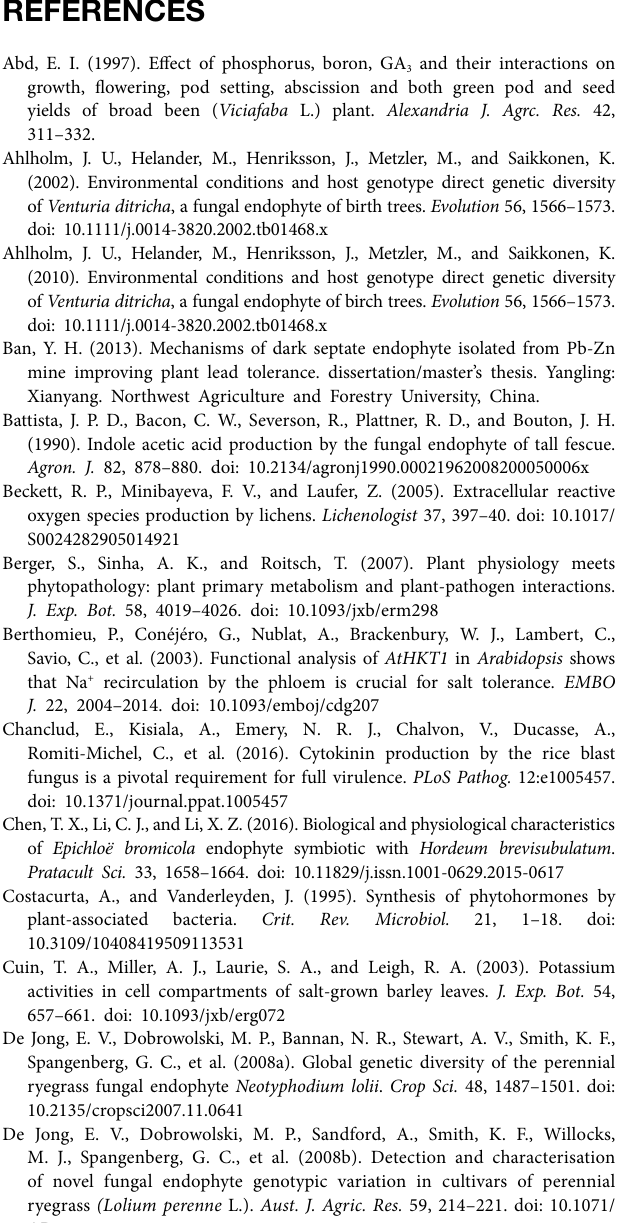
hypha diameter and mycelia biomass of Epichloë sinensis strains in the present study. Supplementary Table 2 | Univariate analysis of general linear models was employed to estimate the effects of single factor and their interaction on cytokinins, abscisic acid, gibberlic acis, and indole-3-acetic acid contents of E. sinensis strains in the present study. Supplementary Table 3 | Univariate analysis of general linear models was employed to estimate the effects of single factor and their interaction on pH, total antioxidant capacity, scavenging abilities of superoxide anion radical and hydroxyl radical, and ion contents of E. sinensis strains in the present